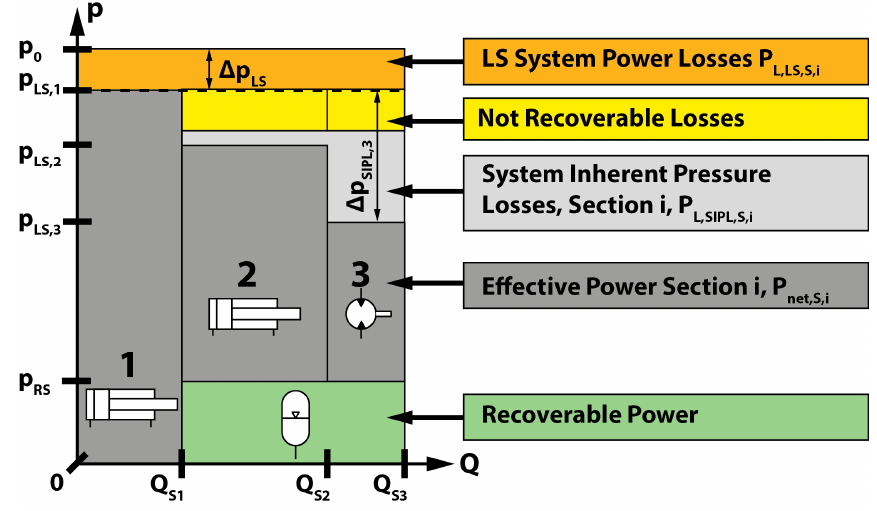
Figure 6. p/Q diagram with reduced system inherent pressure losses [9]. Reproduced with permission from the publisher.